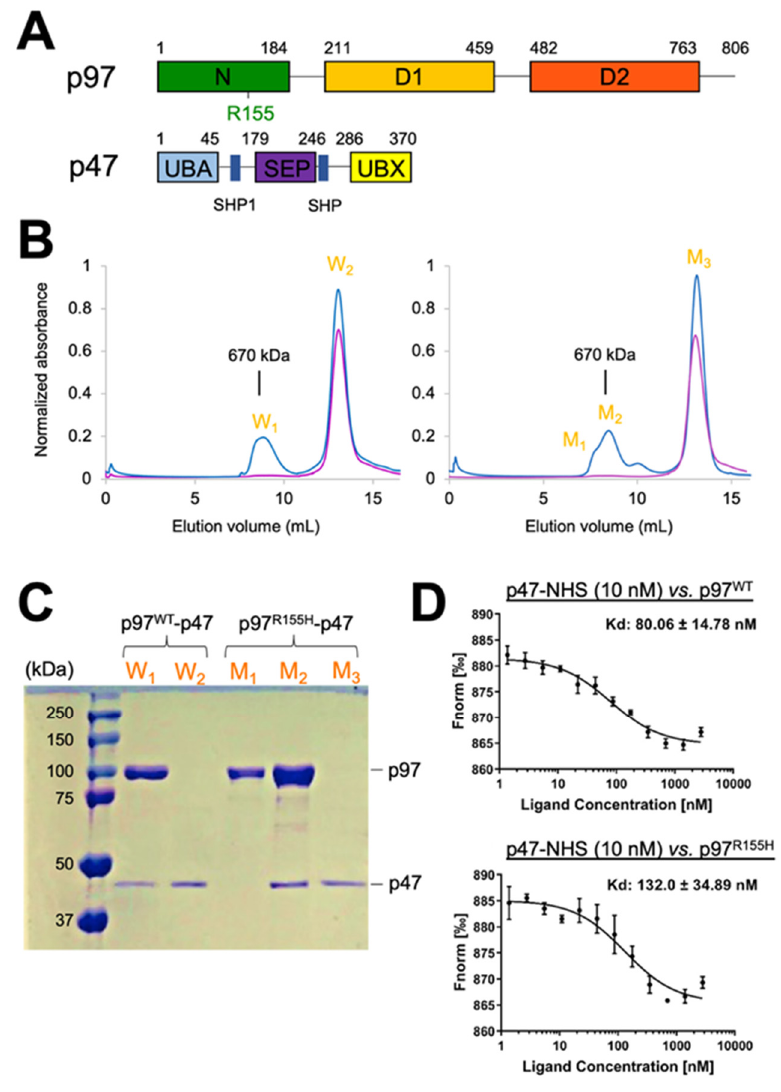
Figure 1. Characterization of the p97 R155H -p47 and p97 WT -p47 complex formation. ( A ) Domain structures of the p97 ATPase and its cofactor p47. The disease-linked mutation of R155H is labeled on the NTD of p97. ( B ) Size-exclusion chromatographic (SEC) profiles of the p97 WT -p47 (left) and p97 R155H -p47 (right) assemblies. Blue and purple curves are for the p97-p47 assembly and p47 protein alone. Peak fractions are labeled. ( C ) SDS-PAGE analysis of the SEC eluted peaks of the p97-p47 assemblies. ( D ) Determination of dissociation constants, K d , for the p97 WT -p47 and p97 R155H -p47 complexes. Unlabeled p97 was titrated against 10 nM of RED-NHS-labeled p47 in two-fold steps from 2.80 µM to 1.37 nM. The temperature-related intensity change (TRIC) signals were recorded and plotted against p47 concentrations.